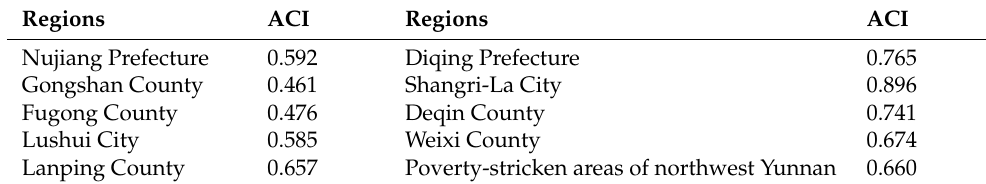
Table 3. Geographical environment ACI of the resettled population in the study area. Regions